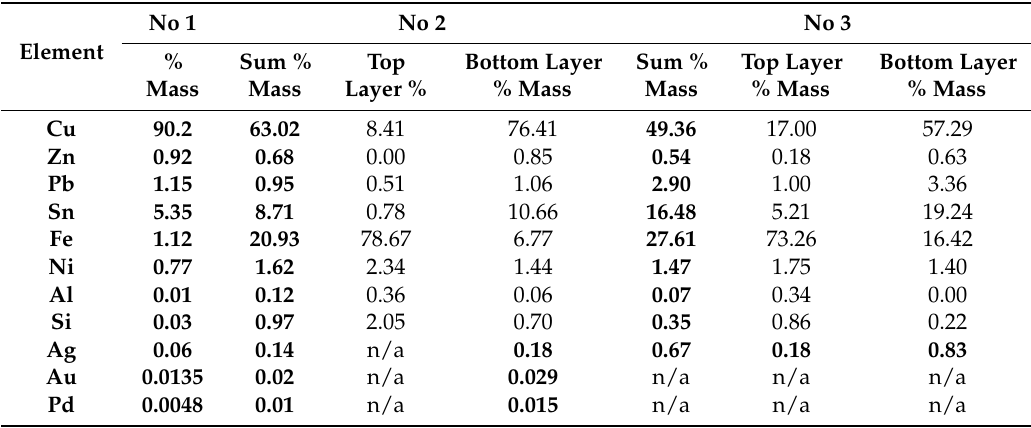
Table 5. Elemental analysis of metal samples: composition of top and bottom layers in remelted ingots No 2, and No